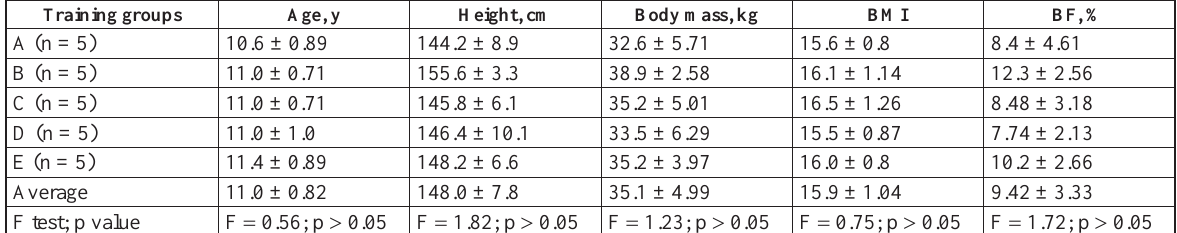
Table 1. Anthropometric characteristics of subjects ( x ±